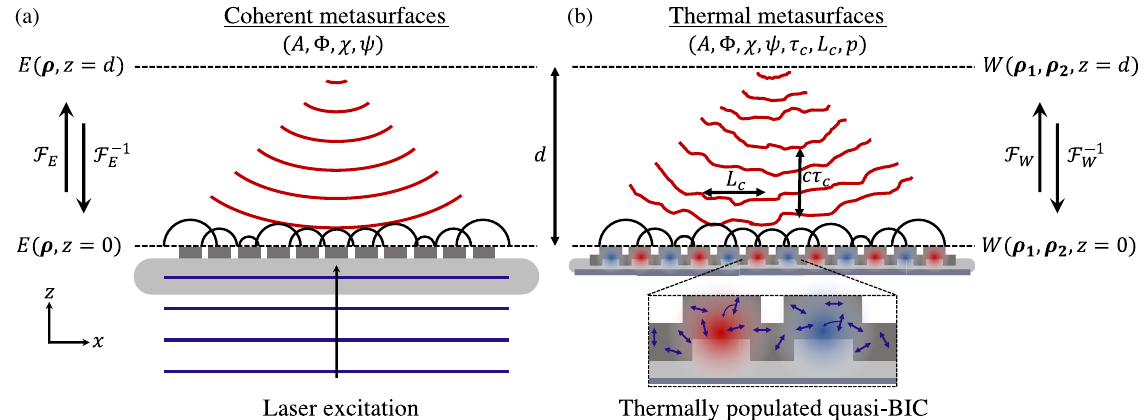
FIG. 2. Comparison of coherent and thermal metasurfaces. (a) A coherent metasurface transforms an incident waveform (blue) into the desired waveform (red) by spatially varying the scattering along the surface, visualized as Huygens ’ wavelets (black). Each wavelet is characterized by a combination of amplitude, phase, and polarization state, which in concert produce the desired far-field profile. The coherence of the system implies that the mapping from metasurface to far field is invertible. (b) A thermal metasurface composed of a patterned structure over a ground plane supporting a thermally populated global mode (blue) whose out-of-plane scattering is locally tailored to produce a partially coherent wave form of